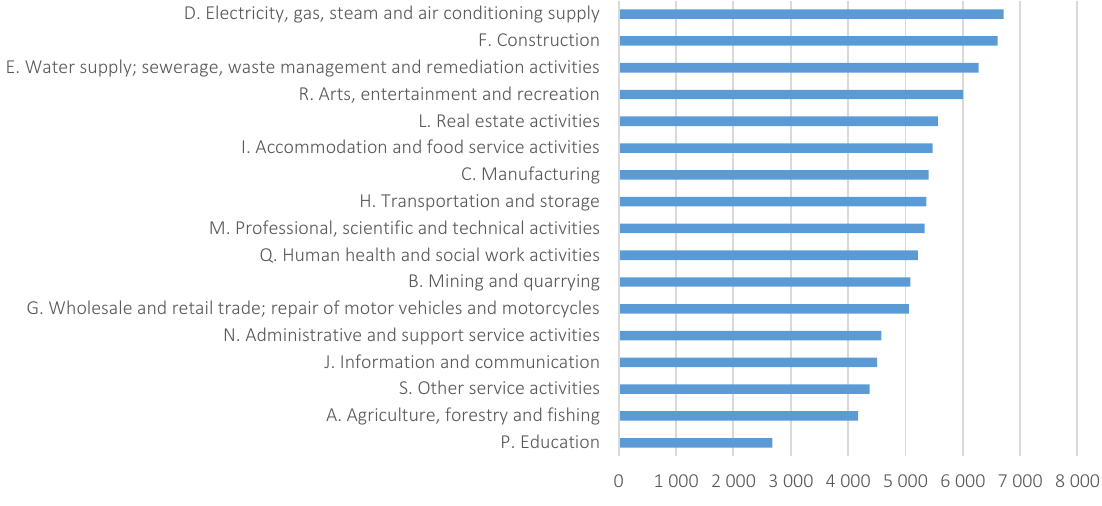
Figure 2. Average electronic file size by industry